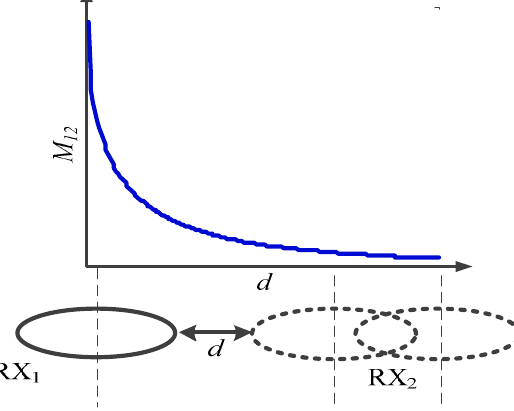
Figure 4. Positional relationship between receiving coils.